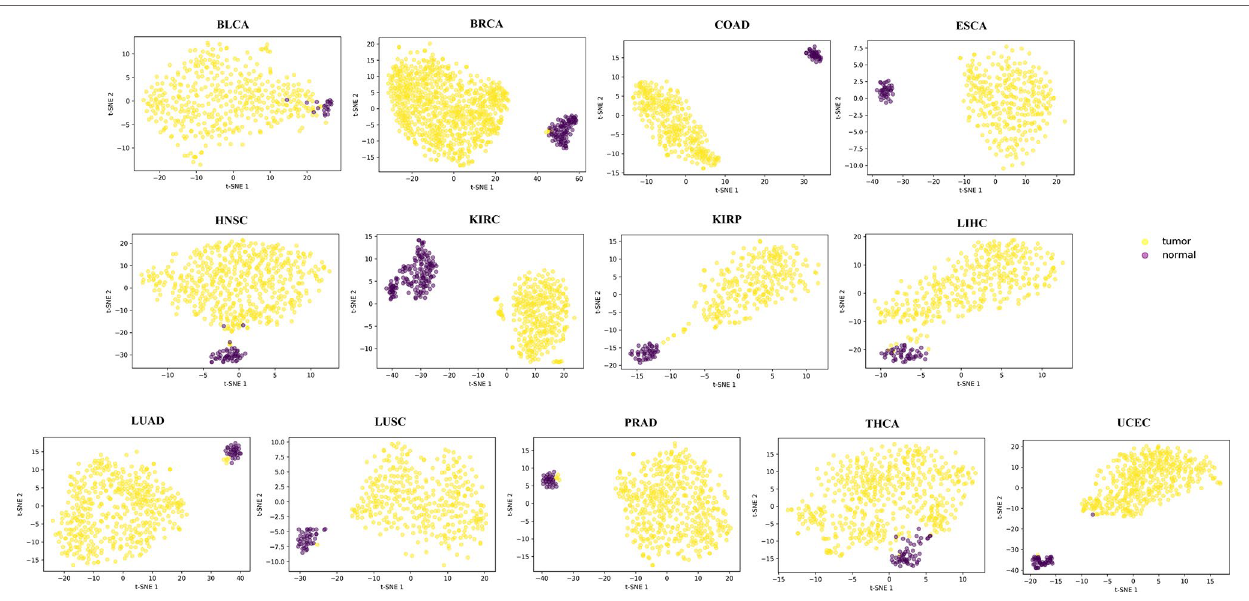
FIGURE 2 | The clustering results by t-SNE using the obtained differential methylation sites for each